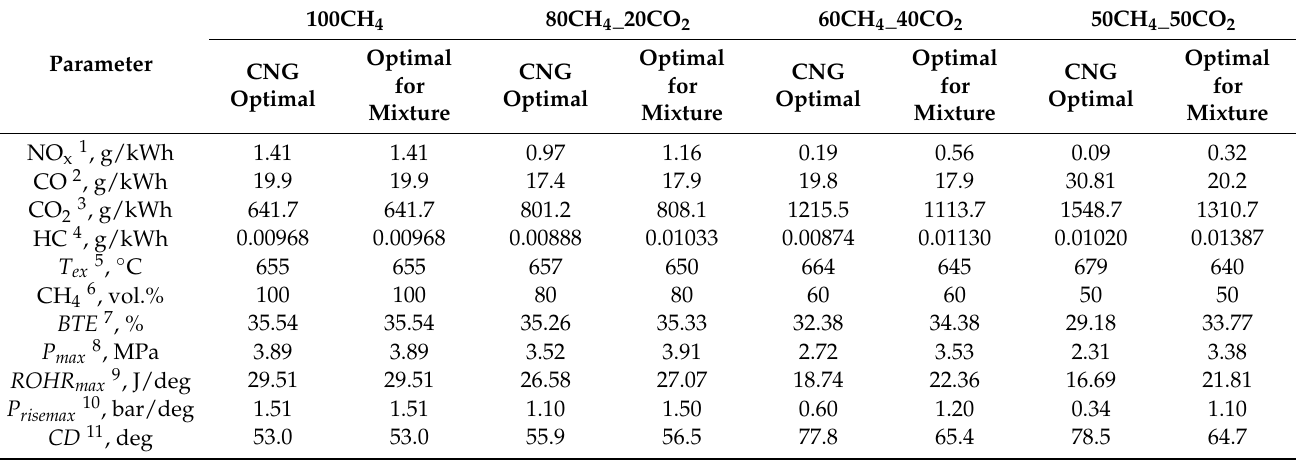
Table 5. Selected parameters and their